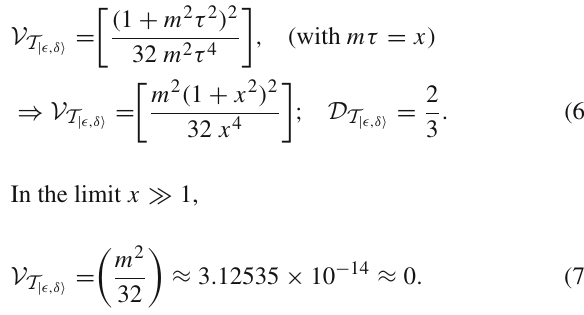
ˆ ζ 2 :(cid:3) , (cid:2): ˆ ζ 2 ˆ π 2 :(cid:3) and (cid:2): ˆ ζ 4 :(cid:3) α α α α